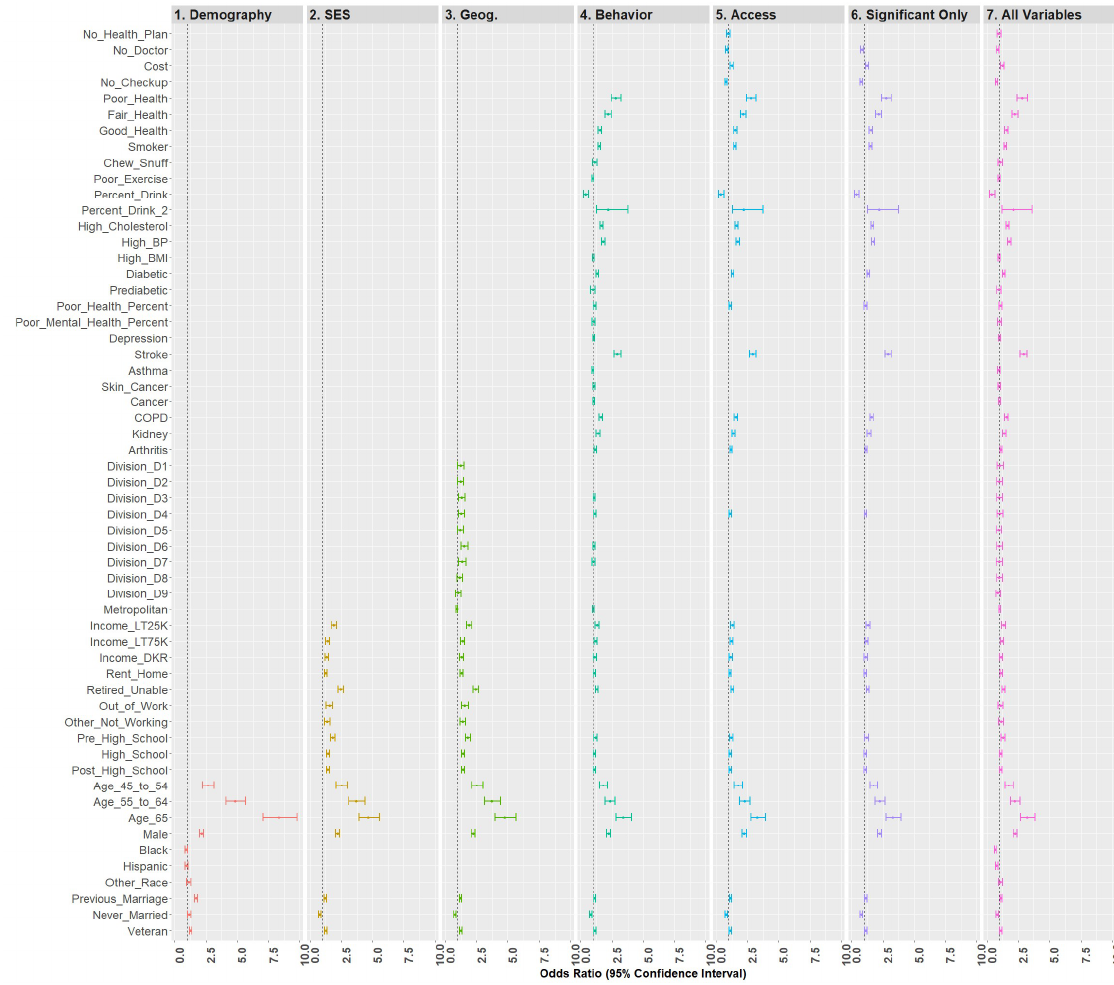
Figure 6. Forest plots of models 1–7.